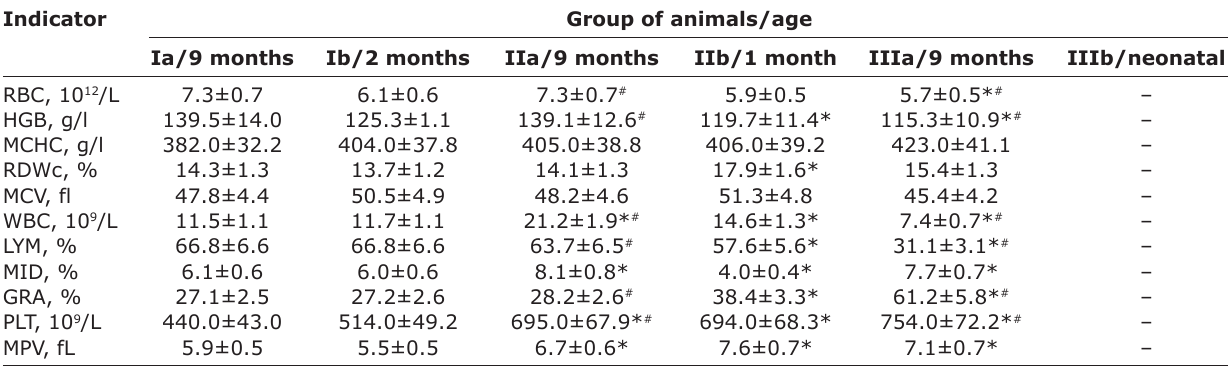
Table-1: Hematological parameters of rats (experiment of 3 months). Indicator